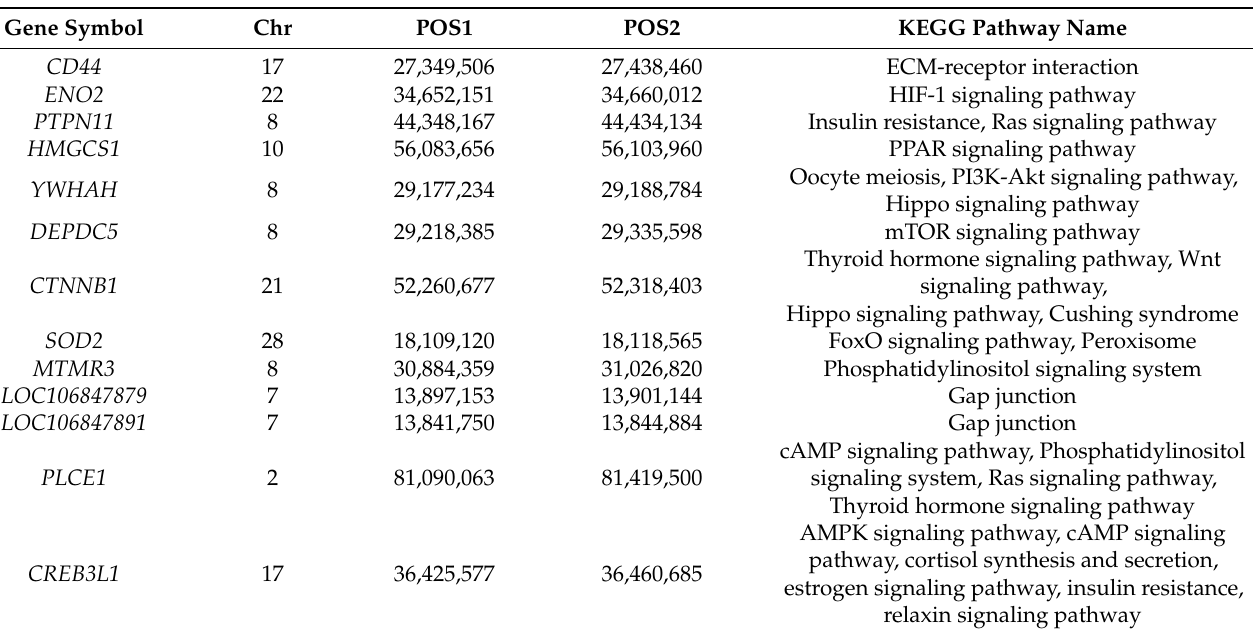
Oocyte meiosis, PI3K-Akt signaling pathway, Hippo signaling